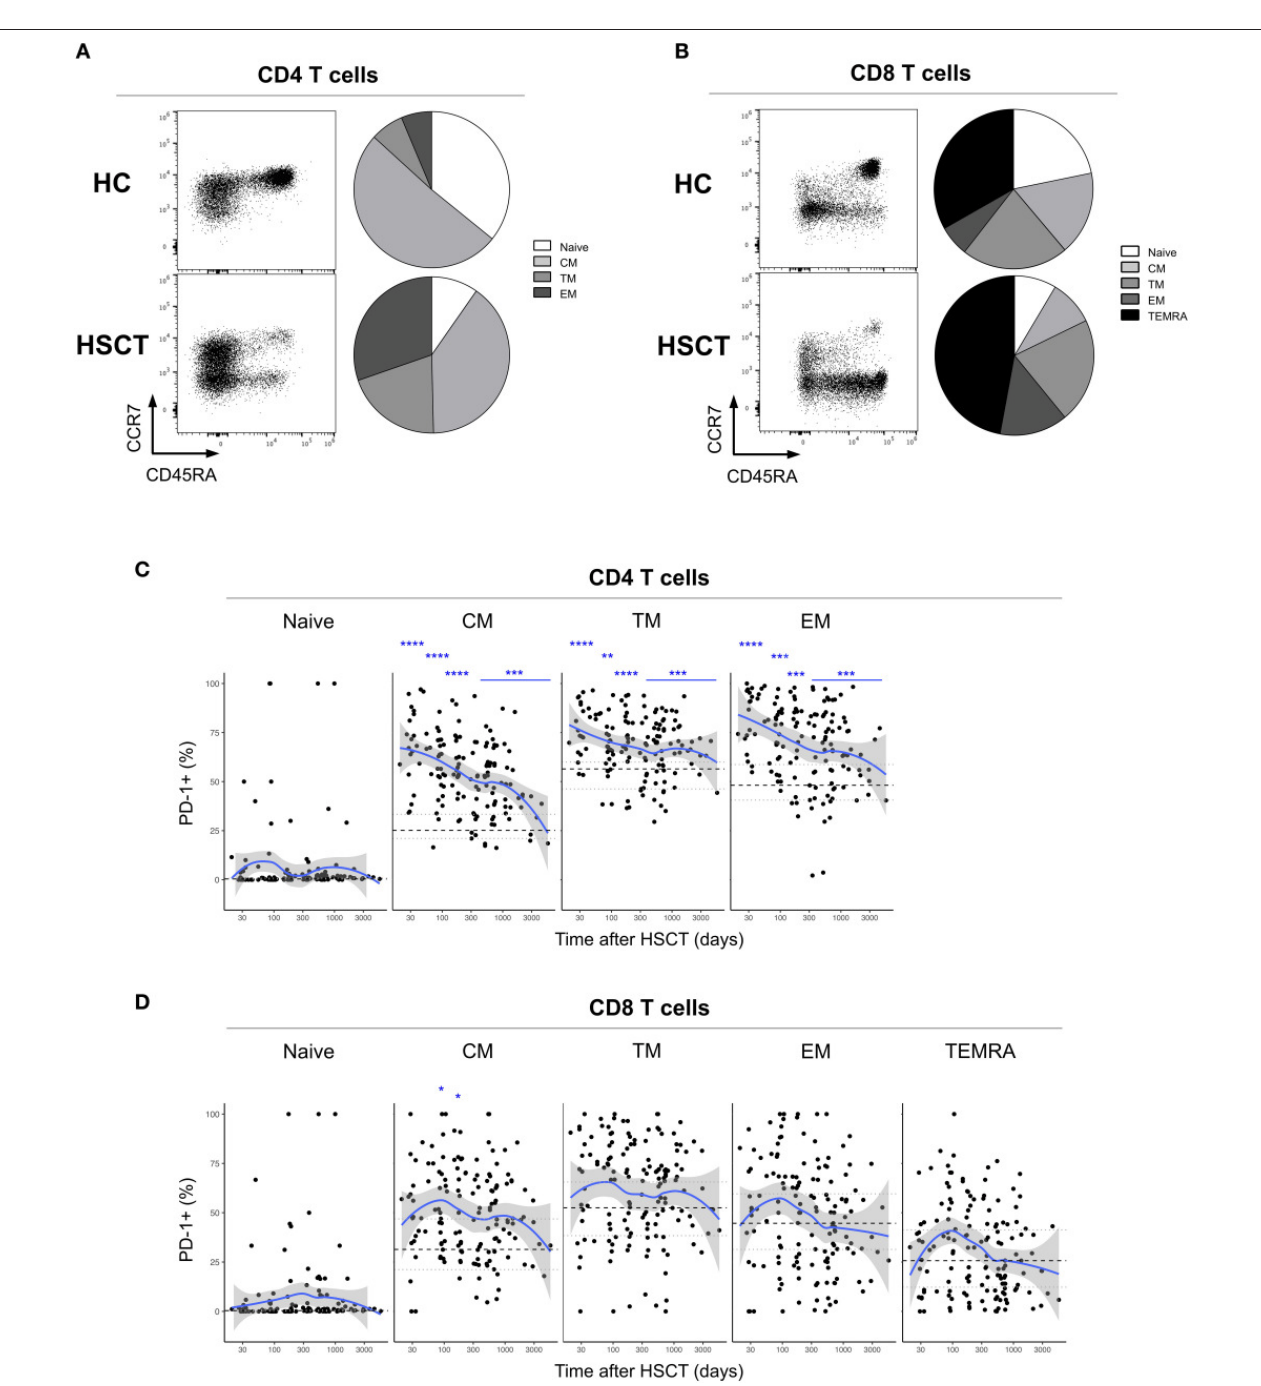
FIGURE 2 | PD-1 expression on CD4 and CD8T cell subsets after allogeneic HSCT. (A,B) Representative FACS dot plots and pie charts representing the proportions of T cell subsets identified based on CD45RA, CCR7, and CD27 expression (Naïve: CD45RA + CCR7 + CD27 + ; central memory (CM): CD45RA- CCR7 + CD27 + ; transitional memory (TM): CD45RA- CCR7- CD27 + ; effector memory (EM) CD45RA- CCR7- CD27-; effector memory re-expressing CD45RA (TEMRA): CD45RA + CCR7- CD27-). Different colors correspond to subsets as indicated. (C,D) proportions of PD-1 expressing CD4 (C) or CD8 (D) T cell subsets from HSCT recipients (black filled circles) and their relationship with time since HSCT. Blue lines represent medians and the gray area represents the confidence interval. Median (black dashed line), 25th and 75th percentiles (gray dotted lines) of PD-1 expressing T cells from HC are represented. The p- values of expression in HSCT recipient groups at 1, 3, 6, 12, and > 12 months compared with HC are indicated (Mann-Whitney U -test; * p < 0.05, ** p < 0.01, *** p < 0.001, **** p < 0.0001).